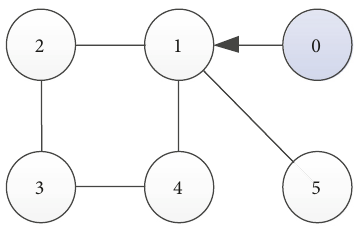
Figure 1: Communication